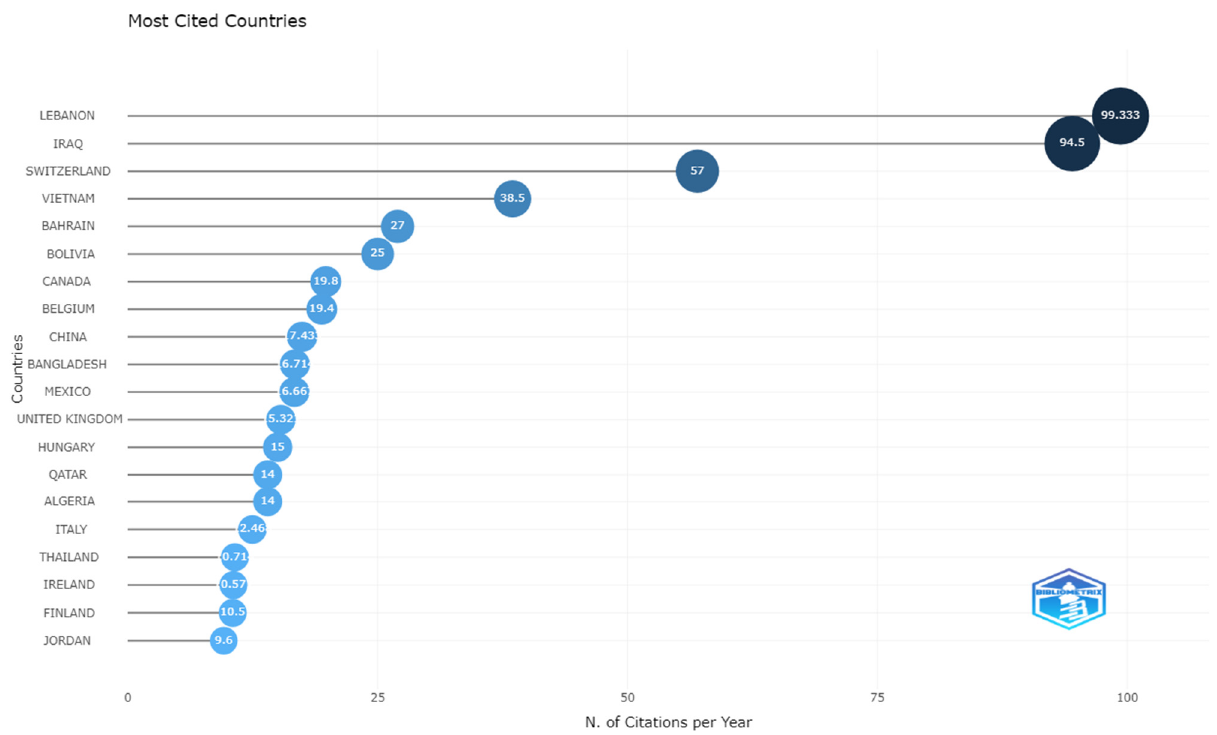
Figure 3. Citations per paper ratio (this chart was generated by Biblioshiny).